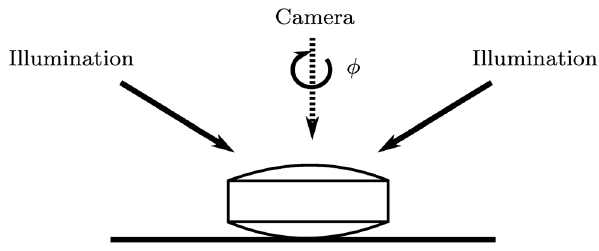
Figure 10. Illumination and camera view geometry. Camera view is parallel to the rotation